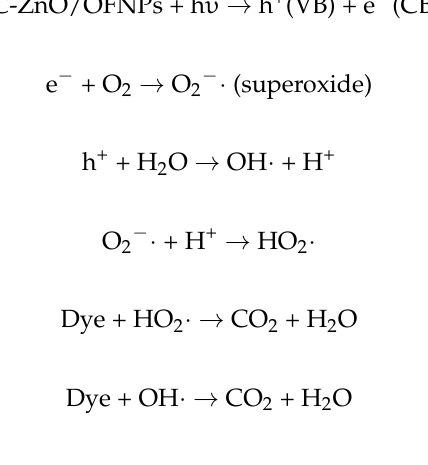
Figure 8. Schematic representation of photodegradation pathway of organic dyes using LC- ZnO/OF.